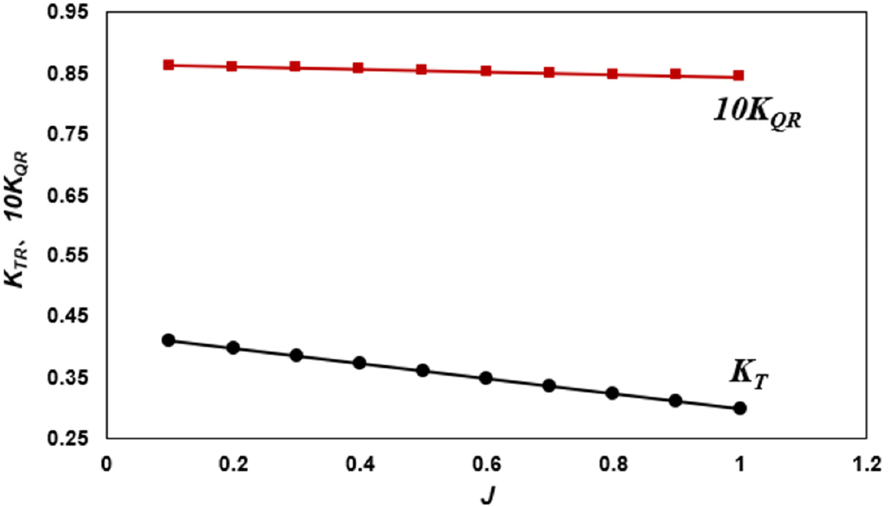
Figure 5. The open-water characteristic of the pump.